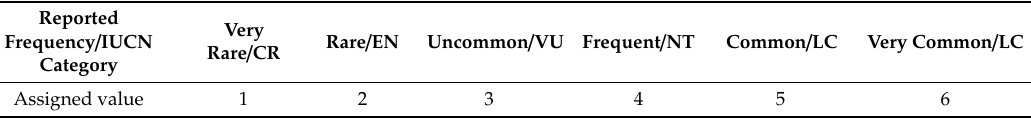
Table 2. Parameterization of the semiquantitative values of abundance recorded in the considered scientific references.